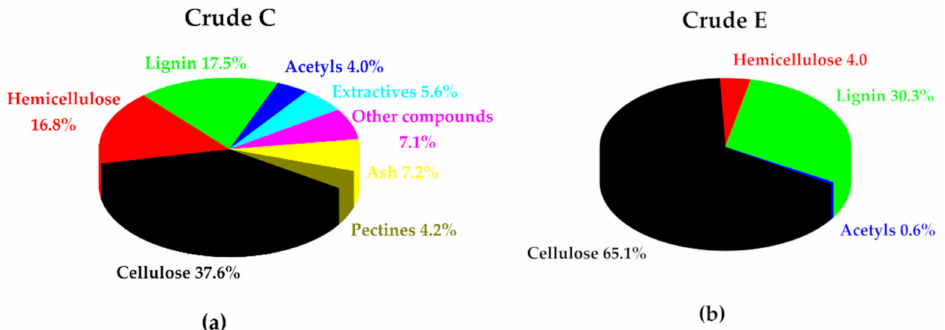
Figure 1. Chemical compositions of untreated cardoon residue ( a ) and the same biomass recovered after a steam-explosion pretreatment ( b ), reported as wt%, on dry